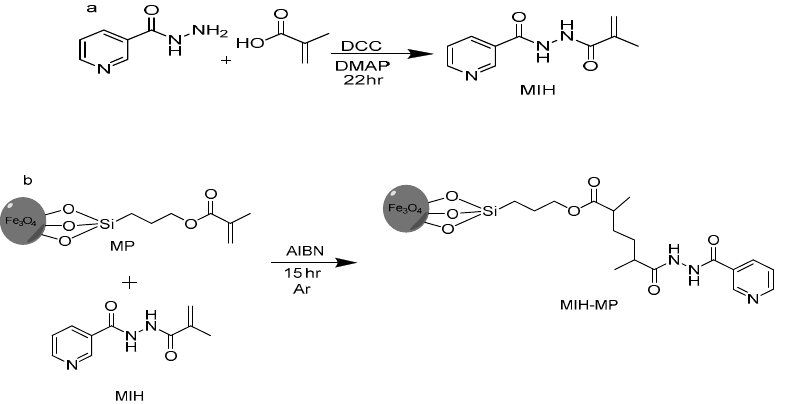
Figure 1. ( a ) Synthetic scheme of MIH molecule. ( b ) MIH-MP